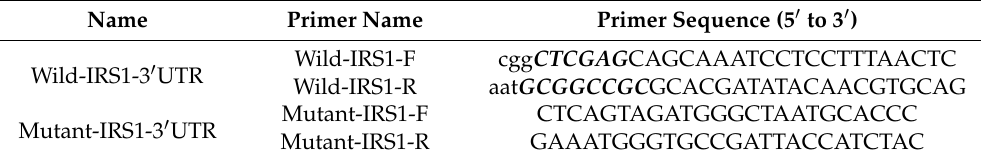
Table 3. The primers used to construct the